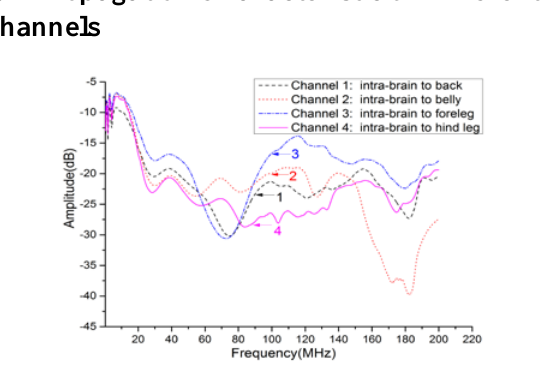
Figure 5. The characteristics of amplitude in four channels.